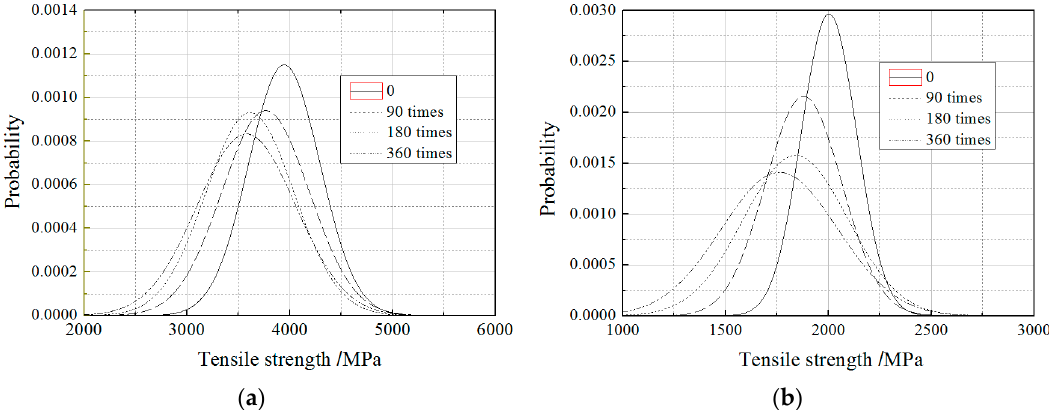
Figure 4. Probability distribution of FRP tensile strength: ( a ) CFRP; and ( b ) GFRP.